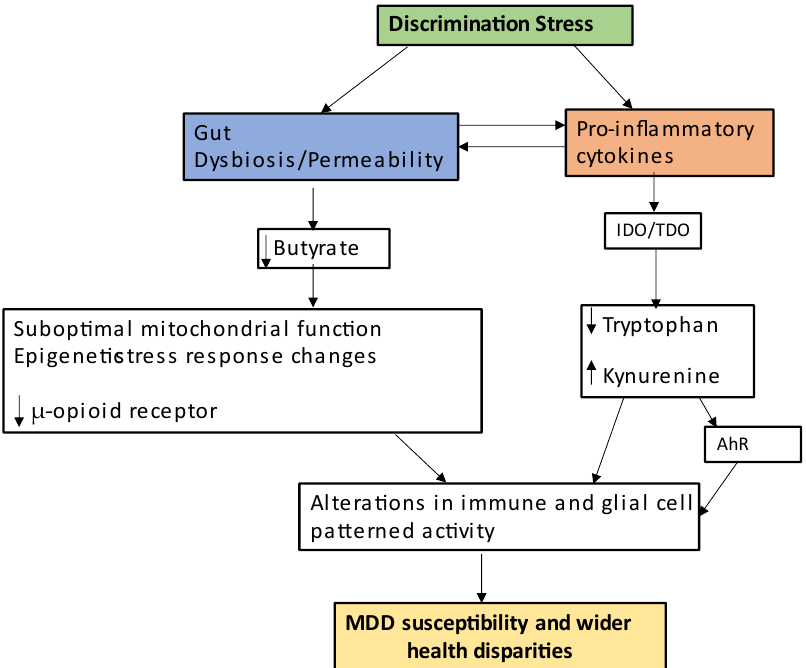
Figure 2. Discrimination stress increases gut dysbiosis and gut permeability as well as pro- inflammatory cytokines, which reciprocally induce each other. The pro-inflammatory cytokine induction of IDO/TDO decreases tryptophan/serotonin/melatonin levels, and consequently in- creases kynurenine. This has mitochondrial, AhR and patterned immune/glia activity consequences. Gut dysbiosis/permeability will also impact on mitochondrial function and patterned immune/glia responses, as well as on wider epigenetic regulation, coupled to a decrease in µ -opioid receptor. This has consequences for the health disparities evident across a range of medical conditions, including MDD. Abbreviations: AhR: aryl hydrocarbon receptor; IDO: indoleamine 2,3-dioxygenase; TDO: